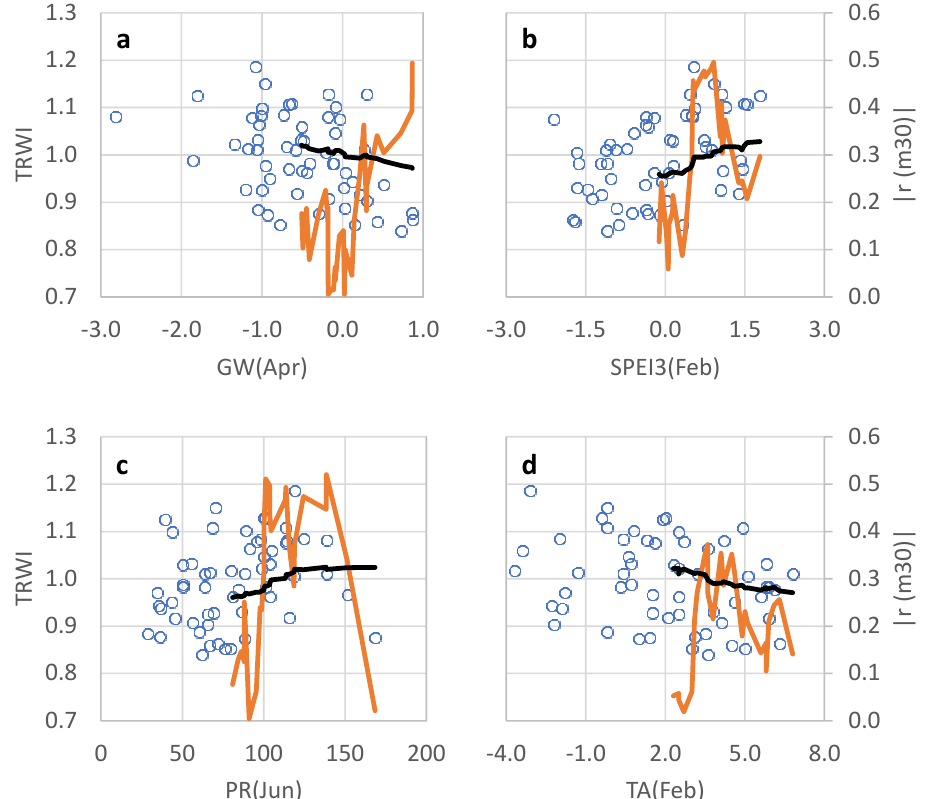
Figure 4. Relationships between TRWI and selected hydro-climatic variables of GW in April ( a ), SPEI3 of February ( b ), PR in June ( c ), and TA of February ( d ) for the common period of 1961–2017, with 30-element moving average trends (MA30; black line). Moving correlation coefficients (r(m30); orange line) in windows of 30 data pairs are also indicated. For MA30 and r(m30) the horizontal axis marks the end value of the moving windows. Differences between mean TRWI values of the first and last MA30 windows are significant in all four cases at p < 0.05 level.